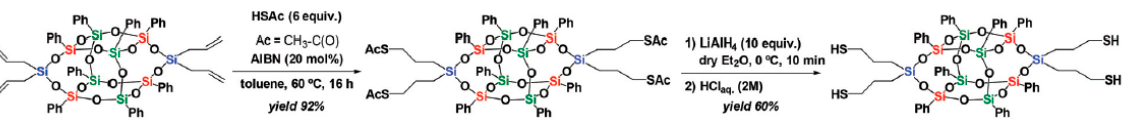
Figure 21. The synthesis of tetra-(3-mercaptopropyl)-DDSQ 3. Republished with permission of Royal Society of Chemistry, © 2021, from Ref. [92].